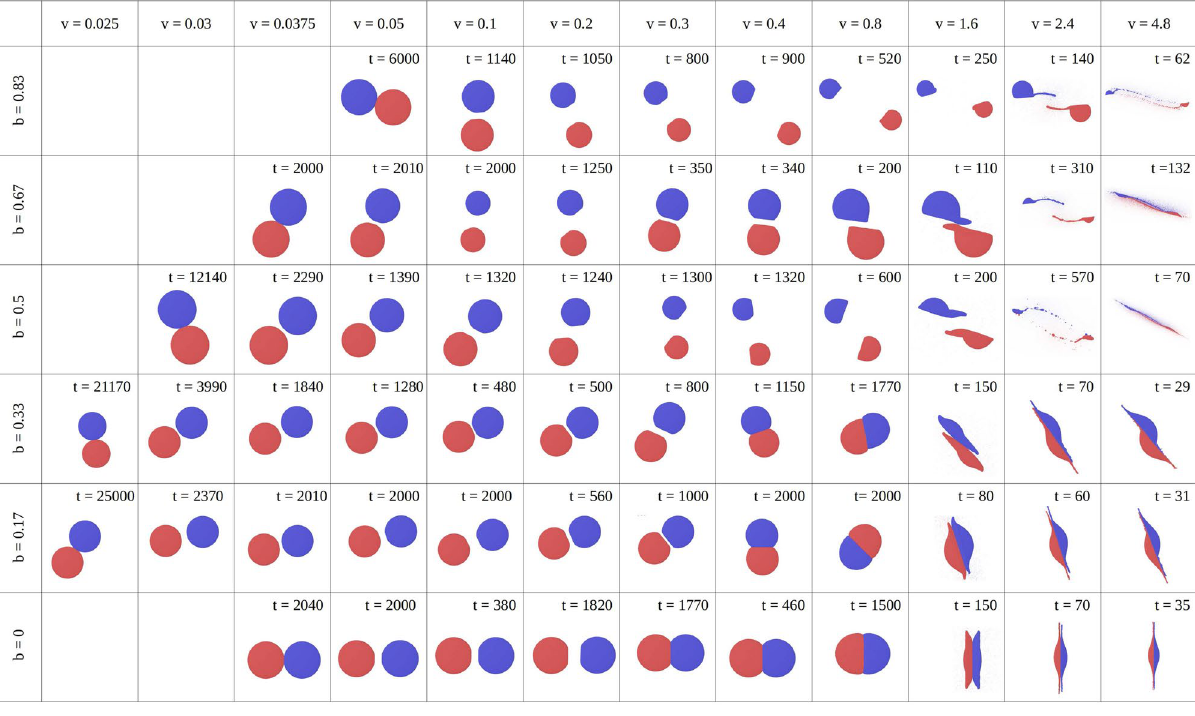
Figure 2. Overview over the post-collision configurations of 2 NPs colliding with velocity v and impact parameter b . Colors denote original association of atoms to NP 1 and 2. Snapshots were taken at the times t indicated, when the collision outcome – bouncing or sticking – can be determined from the separation between the two